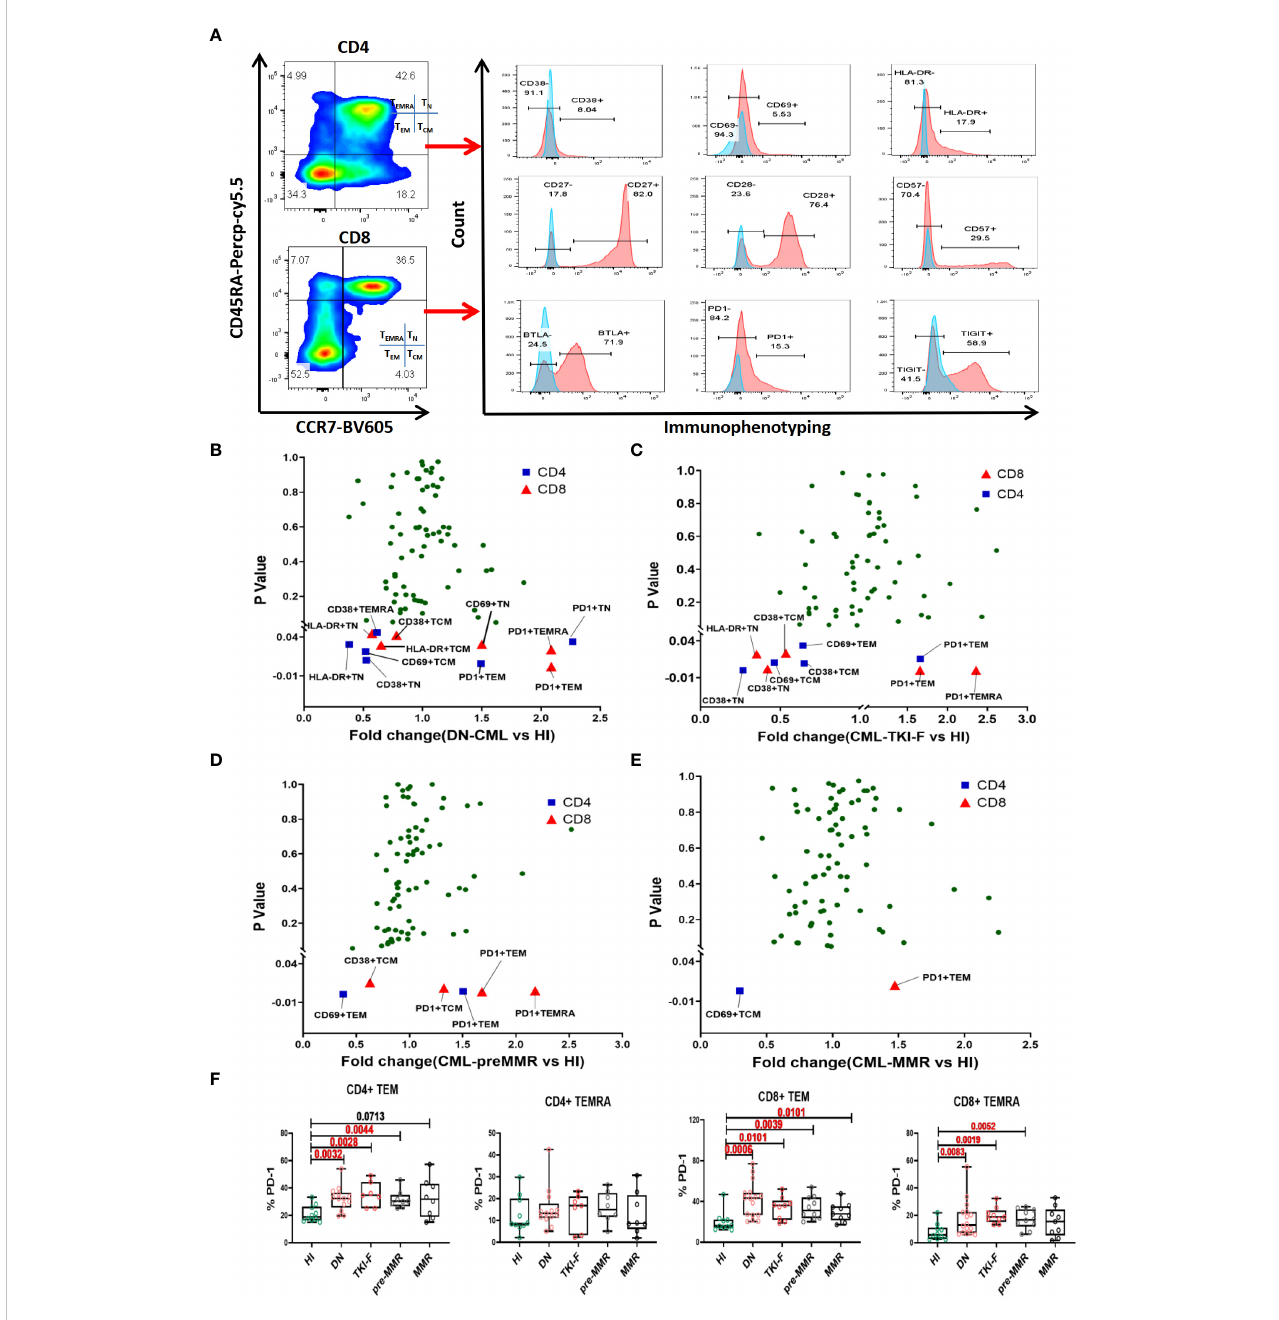
FIGURE 2 The abnormal immunophenotype of PB T cell subsets distributed in DN-CML and TKI-F patients gradually returning to normal in pre-MMR and MMR groups. (A) Gating strategy for the CD4 + and CD8 + T cells subsets in one HI. CD45RA and CCR7 were used to divide the T cells into T N (CD45RA + CCR7 + ), T CM (CD45RA - CCR7 + ), T EM (CD45RA - CCR7 - ), and T EMRA (CD45RA + CCR7 - ) cells. The proportion of the T cell subset single-marker immunophenotypes in HIs and DN-CML (B) , TKI-F (C) , pre-MMR (D) , and MMR (E) patients were compared (Mann-Whitney U test). The P-value plotted on the vertical axis of volcano fi gure. Immunologic characteristics with the mean percentage of fold change (FC) > 1 are enriched in CML patients, and FC < 1 was more frequent in HIs. The blue and red points respectively represent CD4 + and CD8 + T cells. (F) The frequency of PD-1 on CD4 + T EM , CD4 + T EMRA , CD8 + T EM, and CD8 + T EMRA cells in PB from HIs and DN-CML, TKI-F, pre-MMR, and MMR patients. HIs-PB (CD4, n = 10, CD8, n = 10), DN-CML- PB (CD4, n = 13, CD8, n = 16), TKI-F-PB (CD4, n = 7, CD8, n = 9) and MR-PB (CD4, n = 18, CD8, n = 20). The P values shown are from the Mann- Whitney U test between